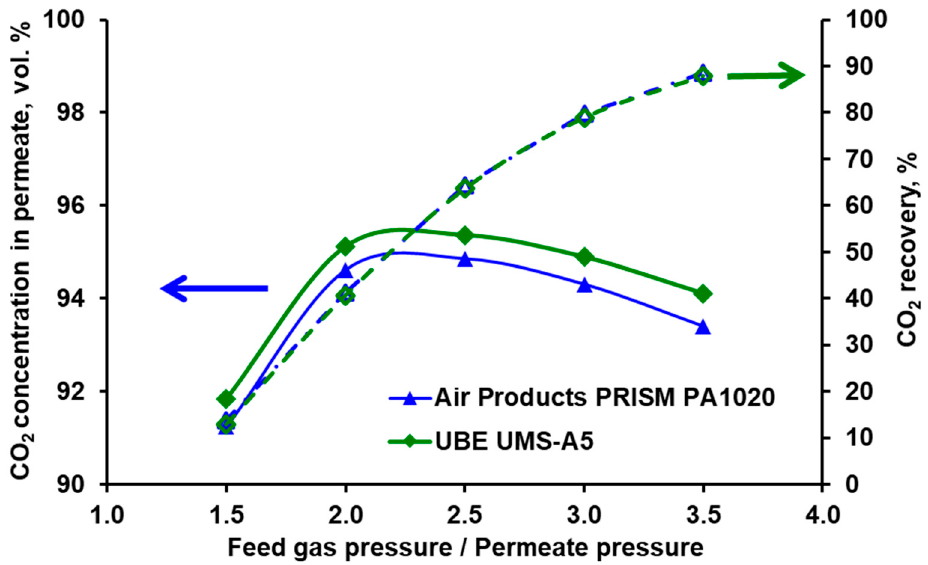
Figure 11. Theoretical CO 2 purity and recovery in Air Products PRISM PA1020 and UBE UMS-A5 modules against feed to permeate pressure ratio for the feed gas flow rate of 0.05 kmol h − 1 and 0.0031 kmol h − 1 , respectively. Feed gas: CO 2 (70 vol.%), N 2 (28 vol.%), O 2 (2 vol.%).